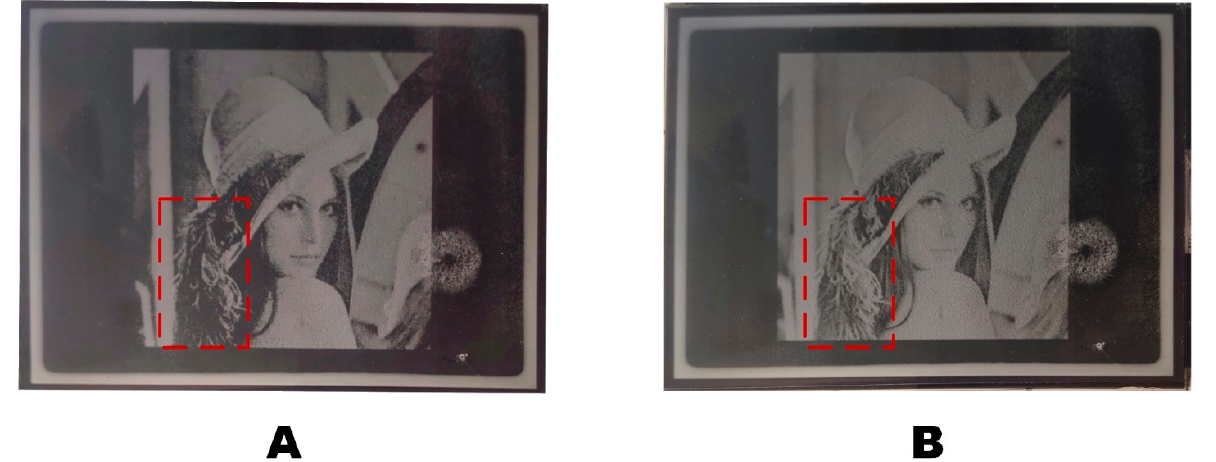
16 of 19 Figure 16. Each driving waveform was applied to a TFT-EWD to display gray scales, the red and purple squares show the difference of grayscale display under different waveforms. ( A ) The EWD driving by a 15 V DC driving waveform. ( B ) The EWD driving by a multi-DC driving waveform. Compared with the DC driving waveform, the ”Lena” image displayed by the multi- DC driving waveform proposed in this paper had richer details and greater brightness, as